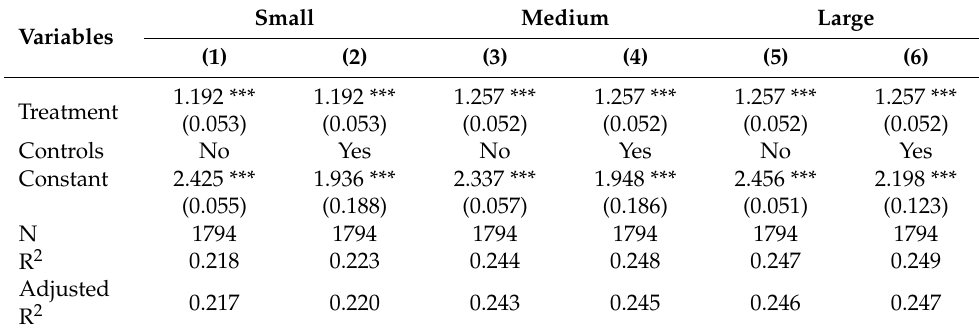
Table A4. The effect of the three types of streets on tourists’ pleasure.